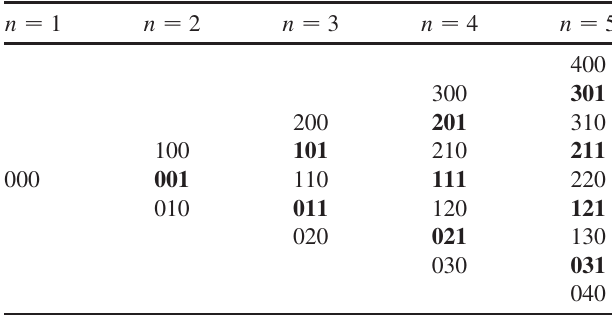
quantum number f n 1 ; n 2 ; j m jg for the first five principal levels. The marked states are excited by a perpendicularly polarized